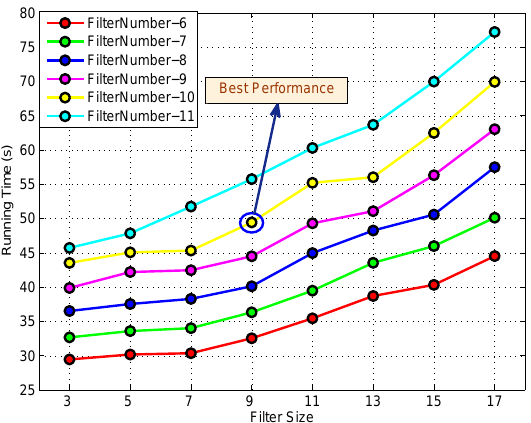
Figure 12. Time consumption of global feature representation with different filter sizes and filter numbers on the UCM dataset. The coordinate point of “best performance” represents that when the SC filters are tested, we achieve the best classification accuracy with 10 filters of a size of 9